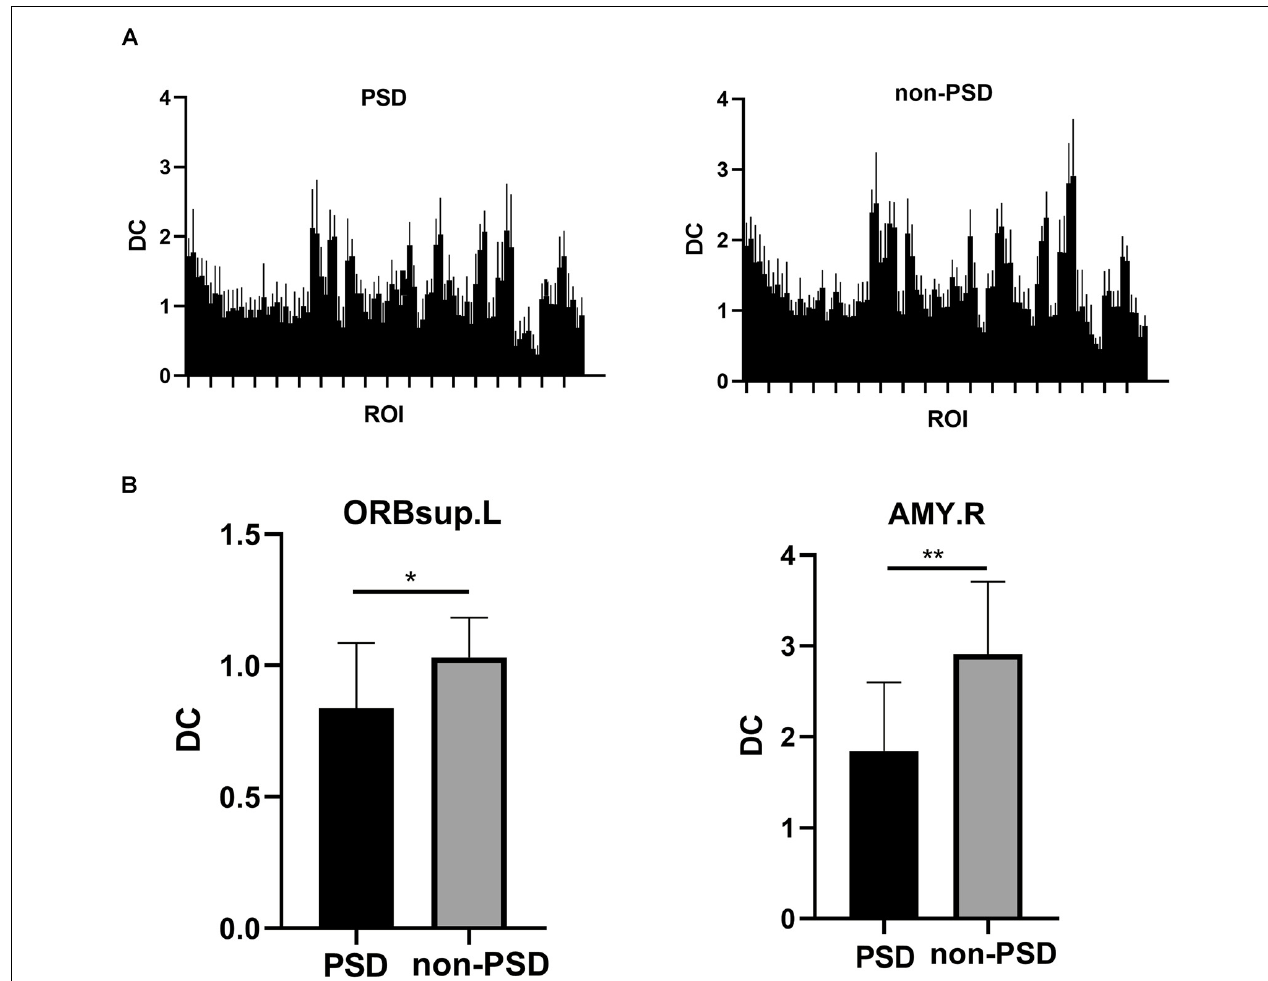
FIGURE 4 | (A) The DC differences between 90 regions of interest (ROIs) of the AAL template in the the PSD and the non-PSD groups. (B) The region with decreased DC in the PSD group was located in the left superior orbital frontal gyrus and the right amygdala (* p < 0.05, ** p < 0.01, FDR correction).DC: Degree centrality. ORBsup: superior orbital frontal gyrus; AMY: amygdala; L: left; R: